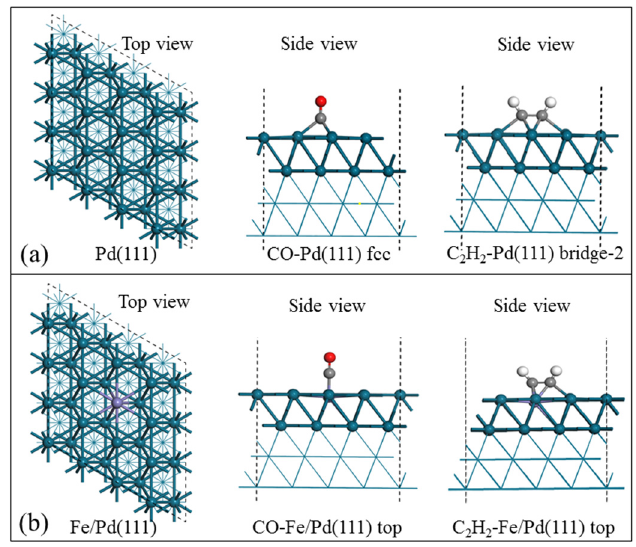
Figure 13. DFT optimized structures. ( a ) Pd (111) and ( b ) Fe/Pd (111), and CO or C 2 H 2 energetically favored adsorption configurations on catalyst surfaces.